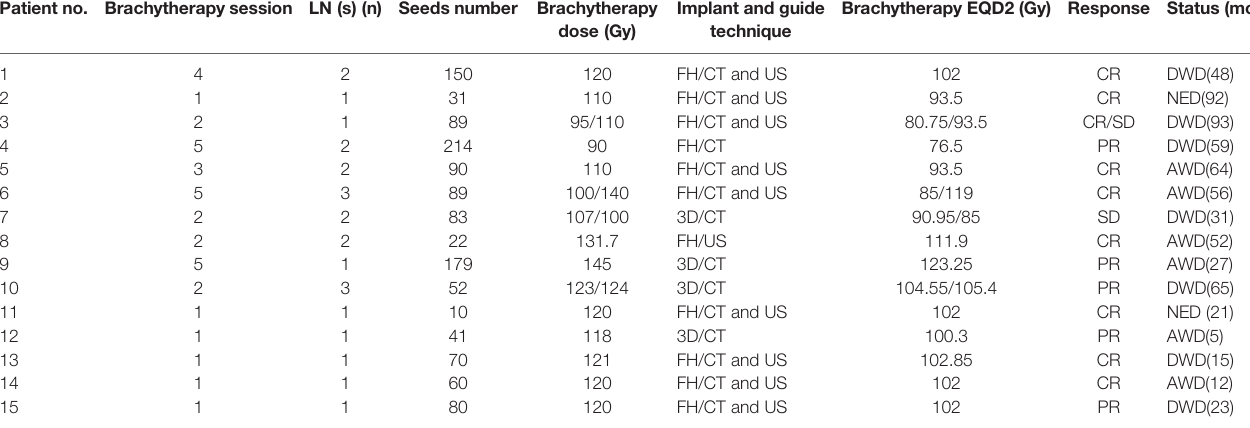
TABLE 2 | Details and outcomes of brachytherapy in fi fteen